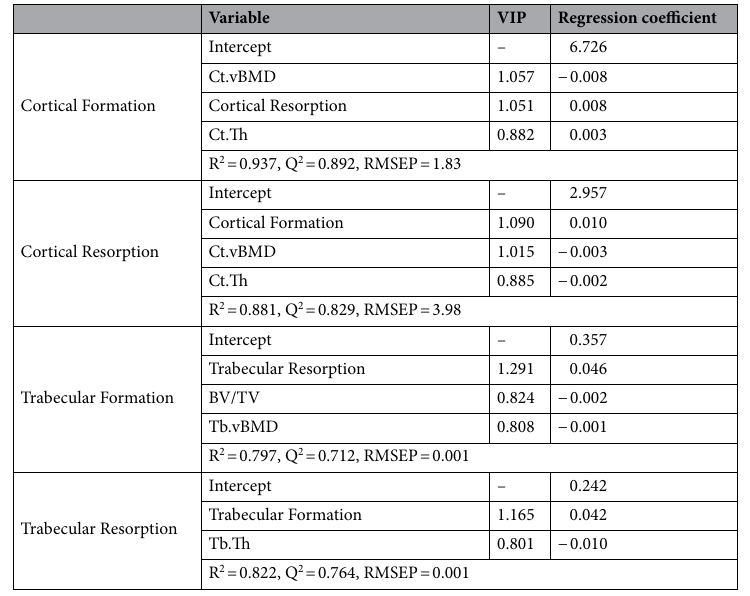
Table 4. PLS regression summary for formation and resorption volume fractions. VIP, variable influence on projection; Ct, cortical; vBMD, volumetric bone mineral density; Th, thickness; BV/TV, total bone volume fraction; Tb, trabecular; RMSEP, root mean squared error of prediction.